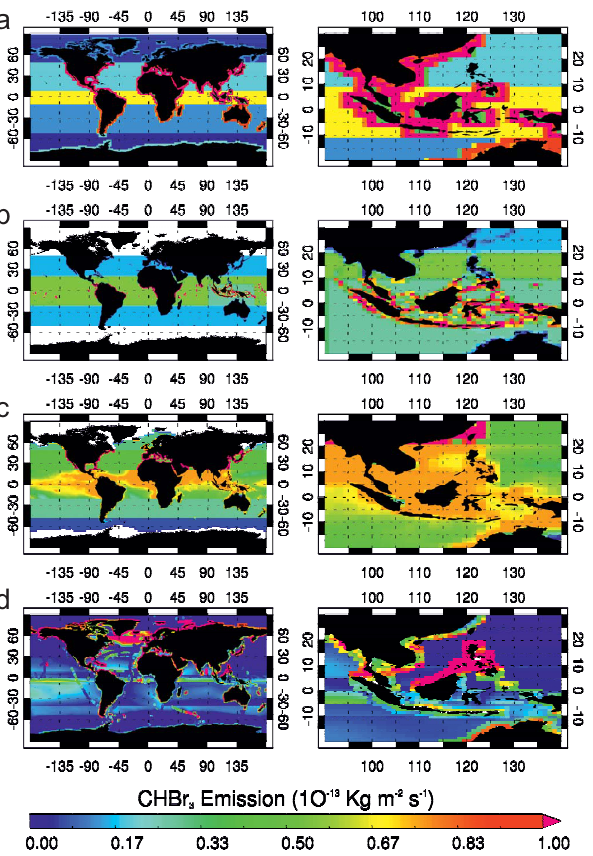
Fig. 2. As Fig. 1 but for dibromomethane (10 − 14 kgm − 2 s − 1 ). Note the change in